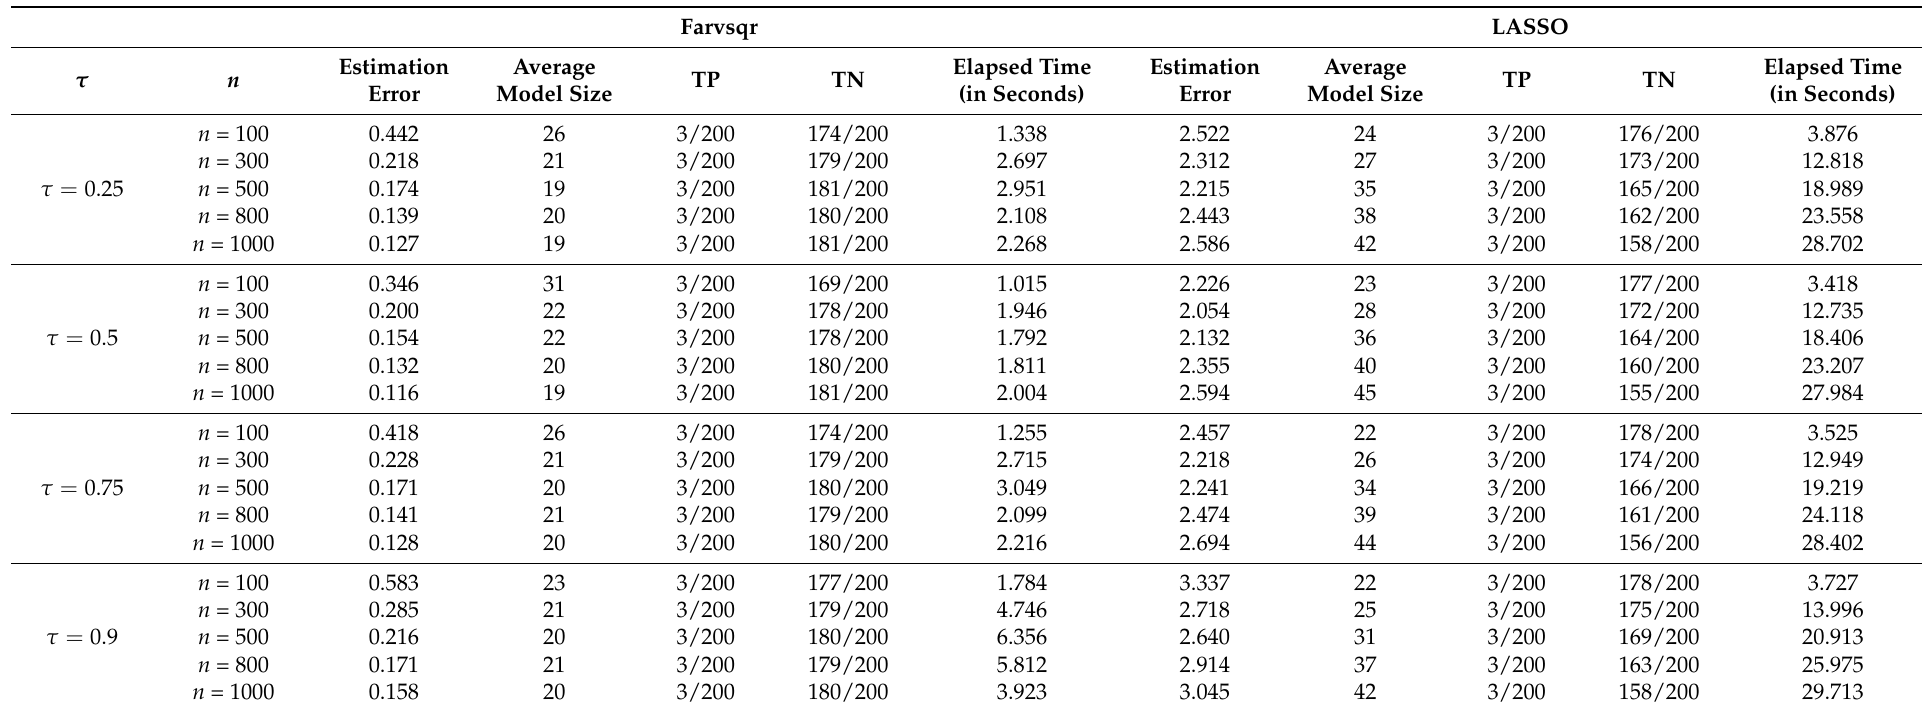
Table 1. The comparison for p = 200, N ( 0,1 ) with the factor model. Farvsqr